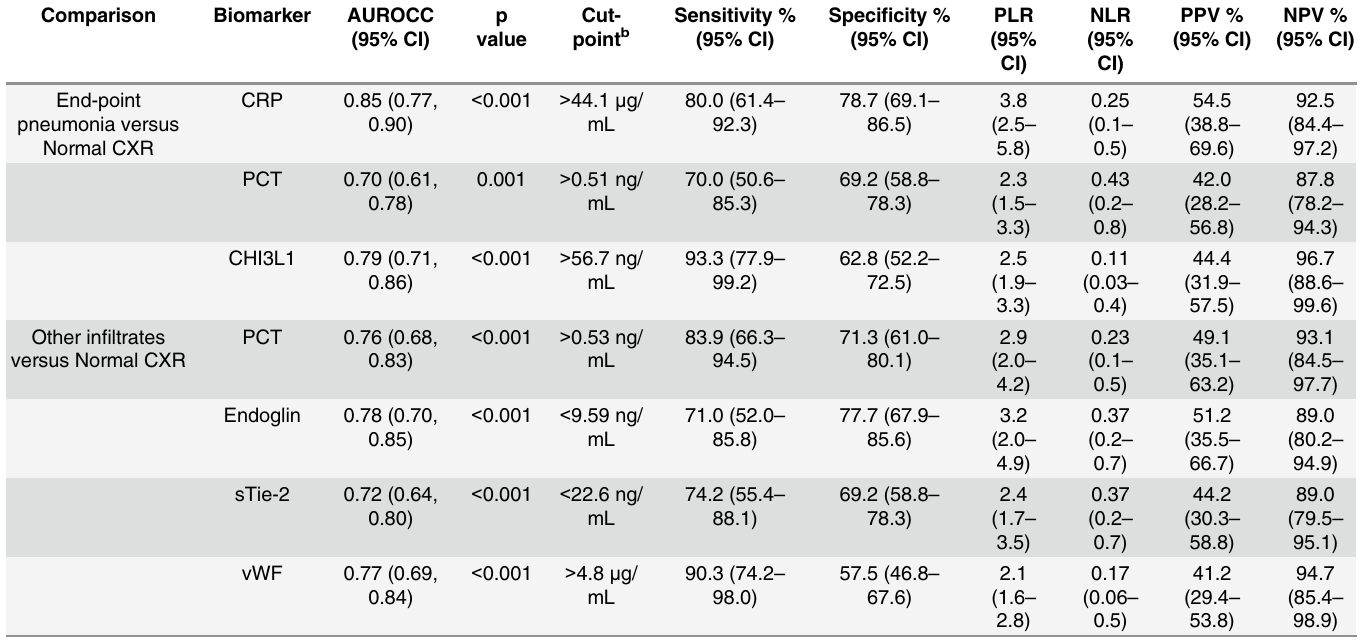
Table 2. Receiver operating characteristic (ROC) curves and cut-points of biomarkers that significantly discriminate between radiological findings. a